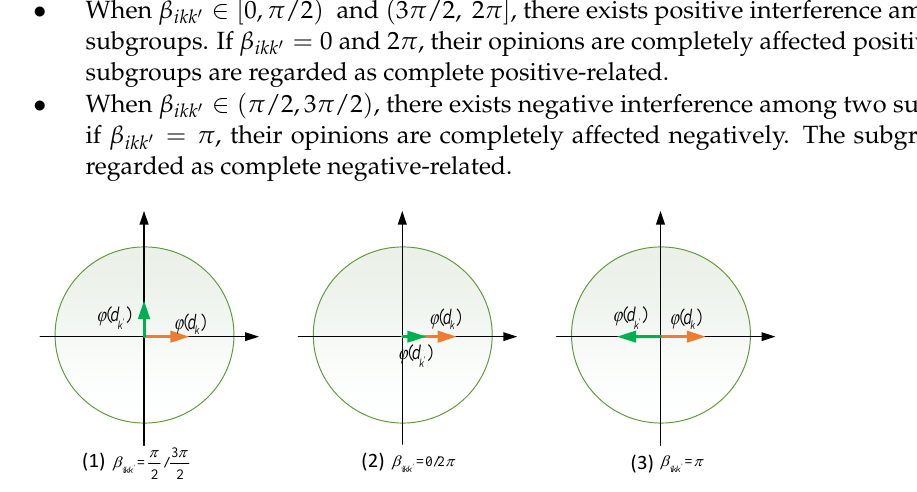
Figure 8. Different phases of the two subgroups of alternative 𝑥 𝑖 .